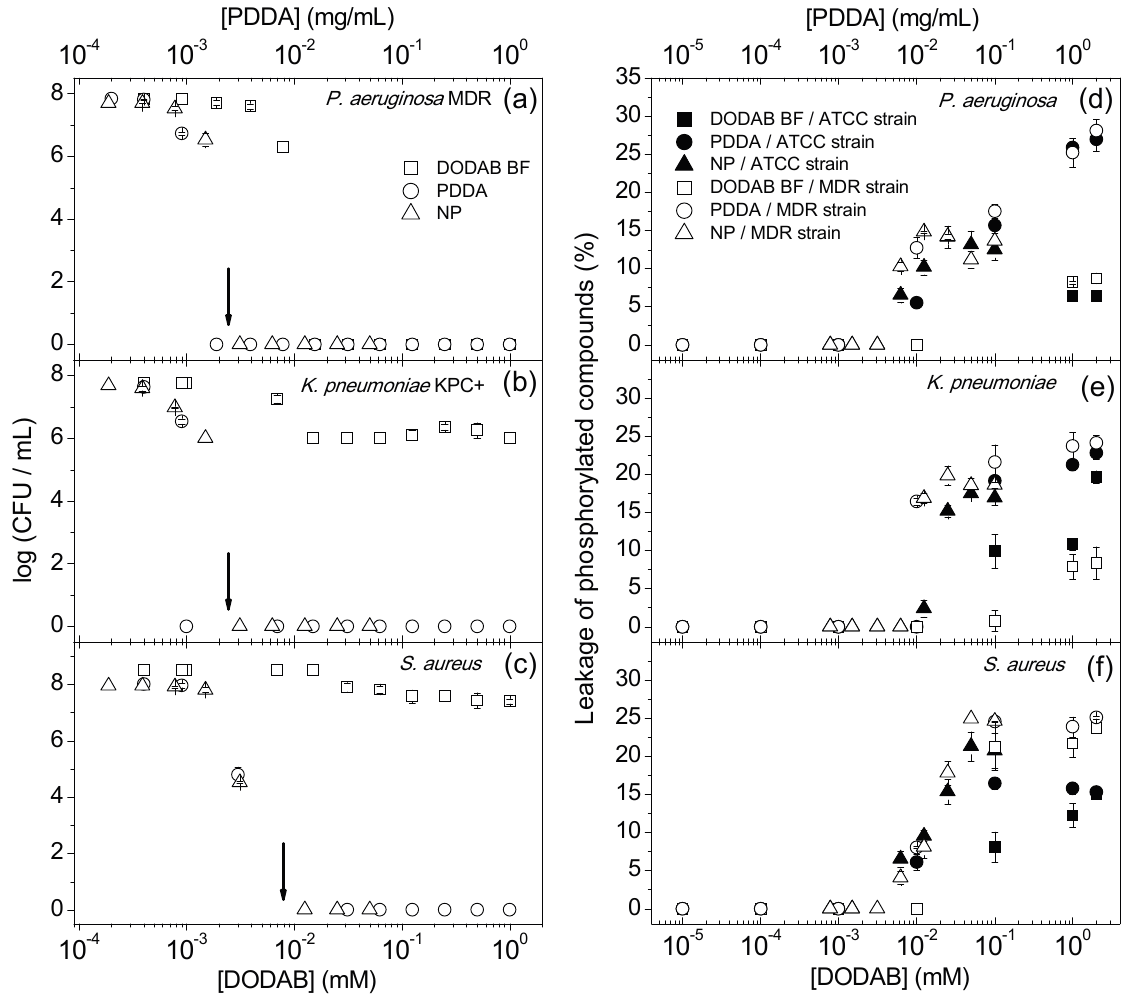
Figure 1. ( a – c ) Cell viability as a function of DODAB or PDDA concentrations for the P. aeruginosa multidrug-resistant (MDR) strain (5–7 × 10 7 CFU/mL), K. pneumoniae KPC+ ( K. pneumoniae carbapenemase (KPC+)) (4–5 × 10 7 CFU/mL) or MRSA (8 × 10 7 –3 × 10 8 CFU/mL); ( d – f ) leakage of phosphorylated compounds (%) as a function of DODAB or PDDA concentrations for reference (ATCC) or MDR P. aeruginosa (2 × 10 8 –5 × 10 10 CFU/mL), K. pneumoniae (3 × 10 8 –1 × 10 10 CFU/mL) or S. aureus (5 × 10 9 –6 × 10 11 CFU/mL). Interactions took place for 1 h. The minimal microbicidal concentration (MMC) values for PDDA in NPs are indicated by